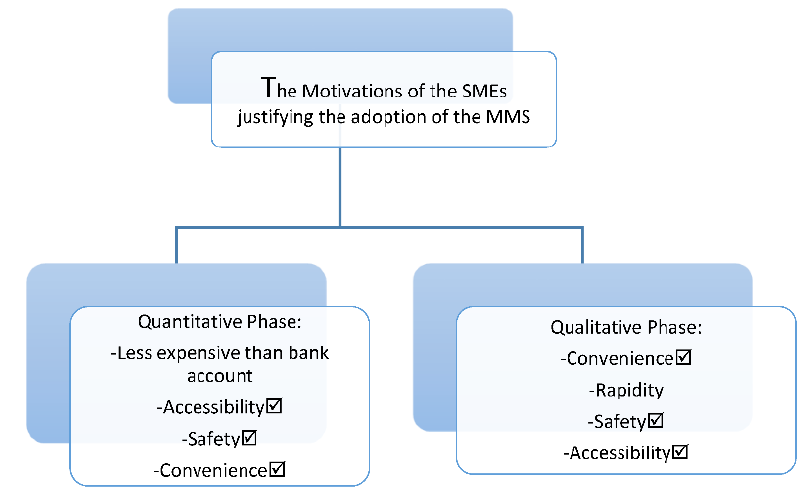
Figure 2. Triangulation of findings (source: authors).